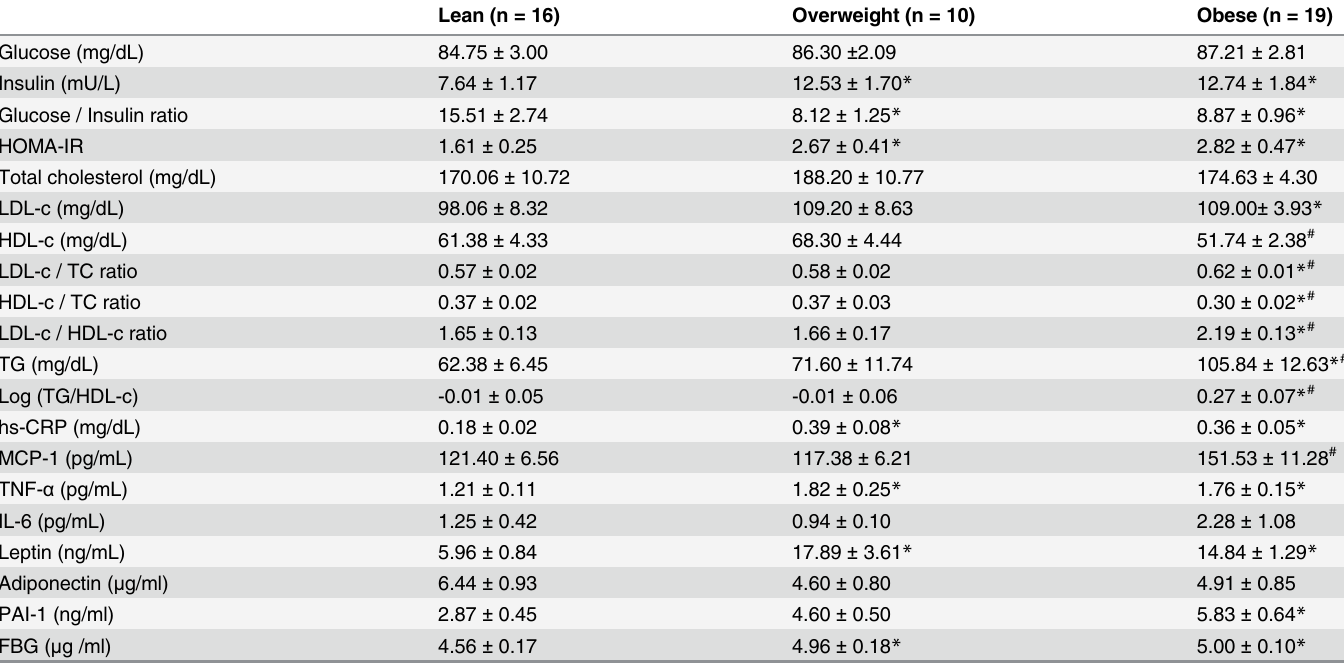
Table 2. Metabolic and inflammatory parameters.